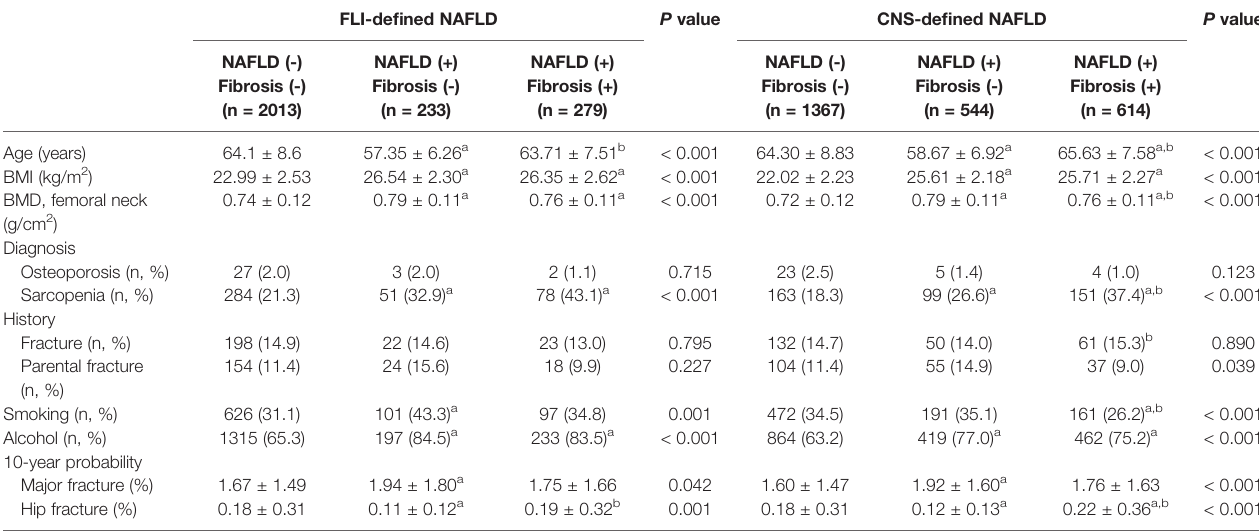
TABLE 1 | Demographic characteristics of the study